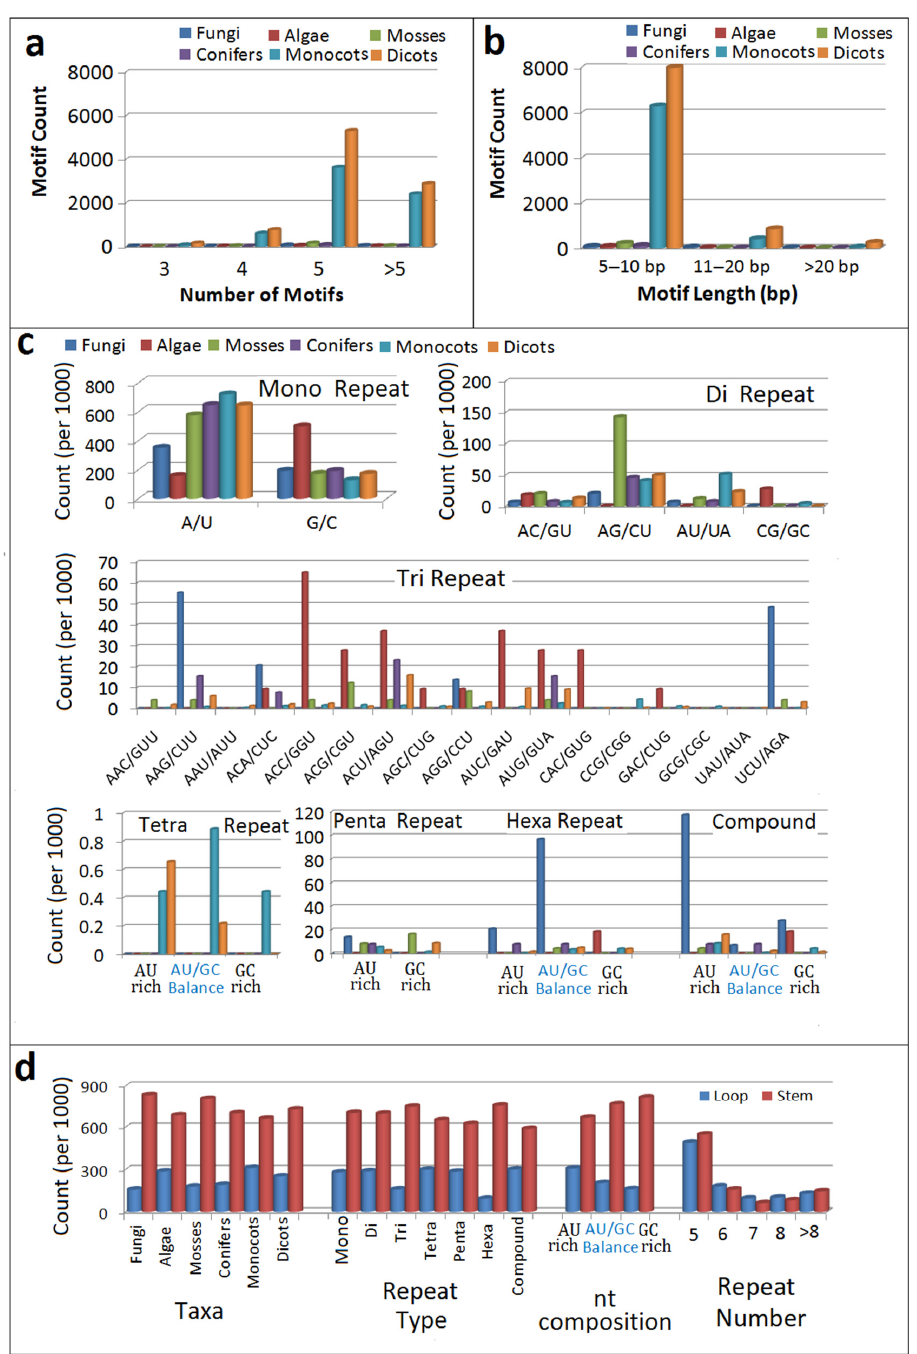
Figure 1. Frequency and distribution of simple sequence repeats (SSR) in pre-microRNAs in six different plant taxonomic groups. ( a ) Frequency distribution of number of SSR motifs; ( b ) frequency distribution of motif length; ( c ) nucleotide base composition of different types of SSR motifs and ( d ) localization of SSR motifs on stem–loop structure among different data sets.